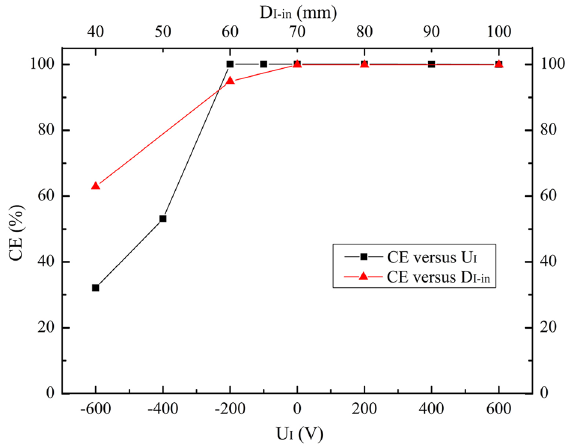
Figure 2. CE versus U I and D I-in over the ranges of − 600 V ≤ U I ≤ 600 V and 40 mm ≤ D I-in ≤ 100 mm.